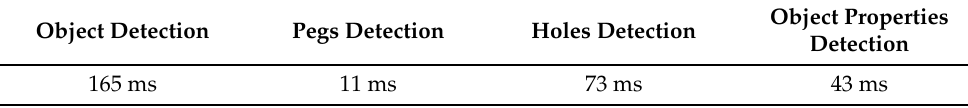
Table 2. Average feature recognition routine run times across five